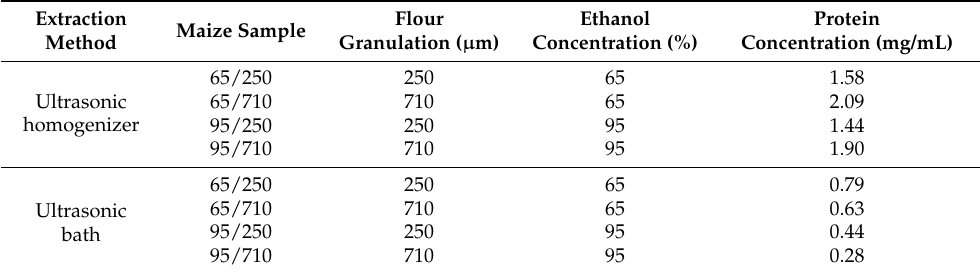
Table 1. Experimental characteristics and concentration (mg/mL) of zein protein extraction from maize kernels using 250 µ m and 710 µ m flour granulation, 65% and 95% ethanol concentration and ultrasonic